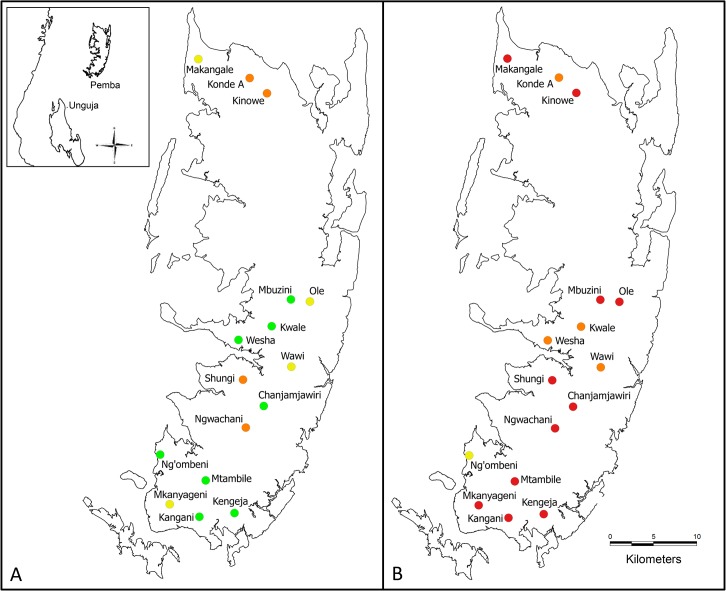
Maps indicating Schistosoma haematobium prevalence levels according to different diagnostic tests.The two maps indicate different S. haematobium prevalence levels as identified with a single urine filtration method (A) and a urine-based up-converting phosphor-lateral flow circulating anodic antigen (UCAA2000) assay (B) in 16 schools on Pemba island, United Republic of Tanzania, in 2013. UCAA2000: up-converting phosphor-lateral flow assay detecting circulating anodic antigen in urine and prepared with 1.5 ml of urine; green spot: school with a prevalence of <2%; yellow spot: school with a prevalence of 2–5%; orange spot: school with a prevalence of 5-<10%; red spot: school with a prevalence of ≥10%.